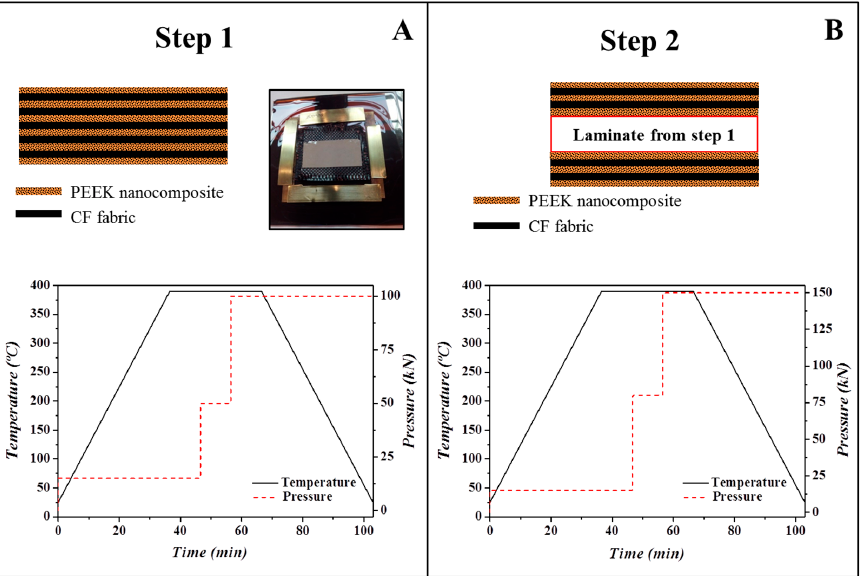
Figure 1. Schematic representation of the stacking sequence and consolidation procedure followed in steps 1 ( A ) and 2 ( B ) for the preparation of PEEK-based laminates.